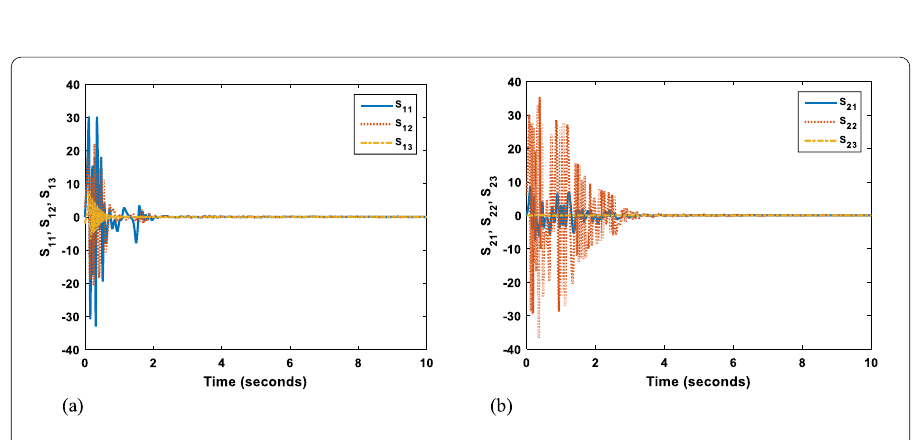
Figure 4 State trajectories of the sliding surface: ( a ) S 11 ( t ), S 12 ( t ), S 13 ( t ) and ( b ) S 21 ( t ), S 22 ( t ), S 23 ( t )